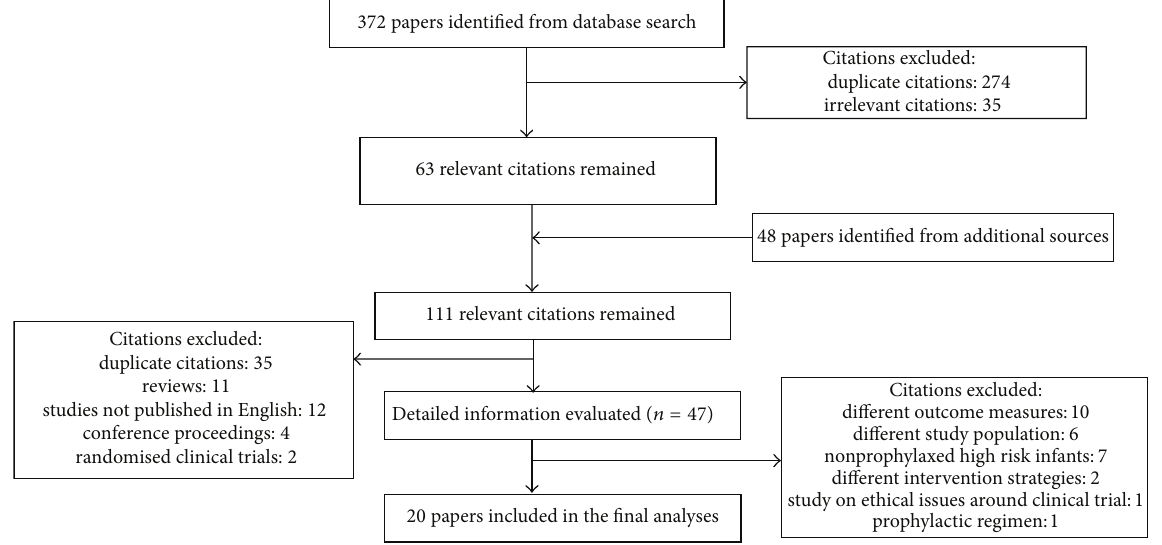
Figure 1: Flow diagram for selection of papers for the review.